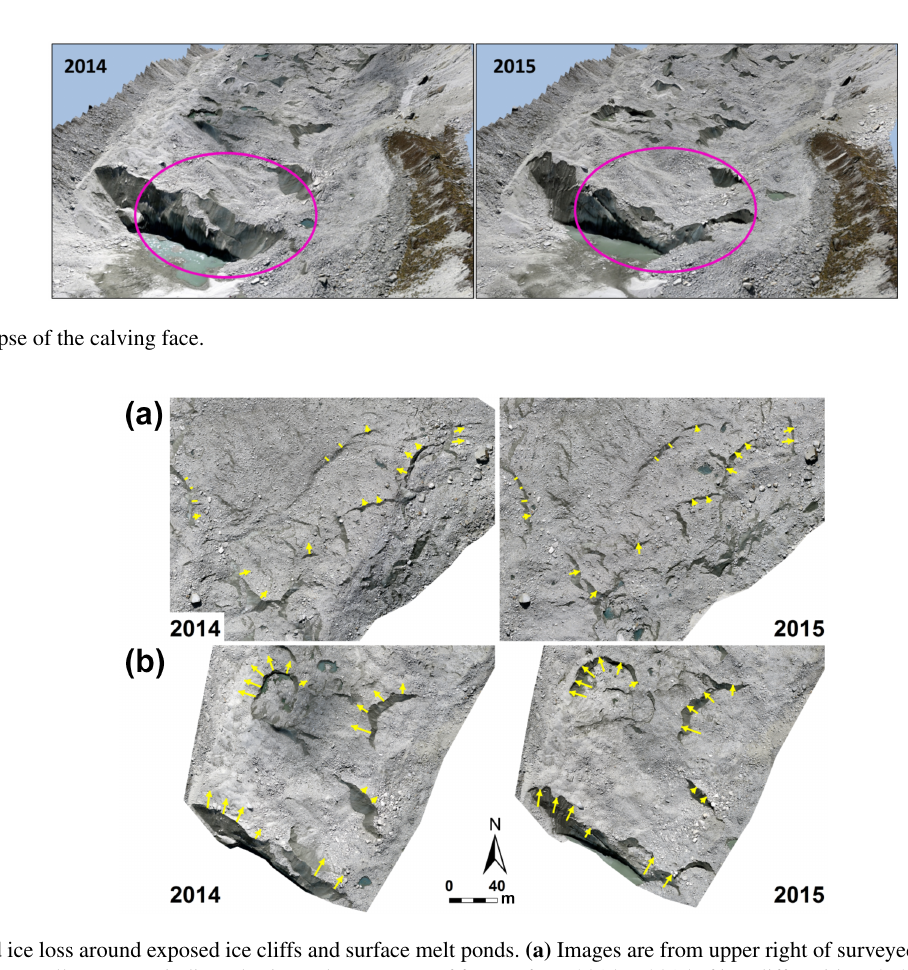
Figure 11. Rapid ice loss around exposed ice cliffs and surface melt ponds. (a) Images are from upper right of surveyed area; (b) images are behind calving face. Yellow arrows indicate horizontal movement of feature from 2014 to 2015 of ice cliff position: 2–25m yr − 1 . More rapid retreat of ice cliffs is observed in the lower glacier, where cliffs are larger and temperatures are warmer. Note: 2015 images have been shifted (georectified) to 2014 positions based on velocity vectors (Fig. 7); i.e. horizontal glacier movement is removed so that the same location relative to glacier surface is compared. Location of panels is depicted in Fig. 7 inset boxes: 2 – upper panels; 3 – lower